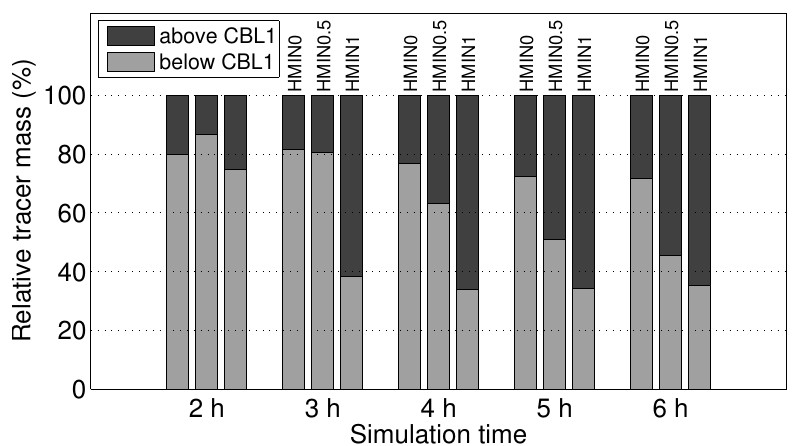
Figure 14. Relative tracer mass located above (dark gray) and below (light gray) the reference CBL height (CBL1) as a function of time. A tracer has been constantly emitted at the valley floor ( − 8km ≤ x ≤ − 7km, see Fig. 13). Shown are all simulations with valleys (from left to right) between 2 and 6h: HMIN0, HMIN0.5, and